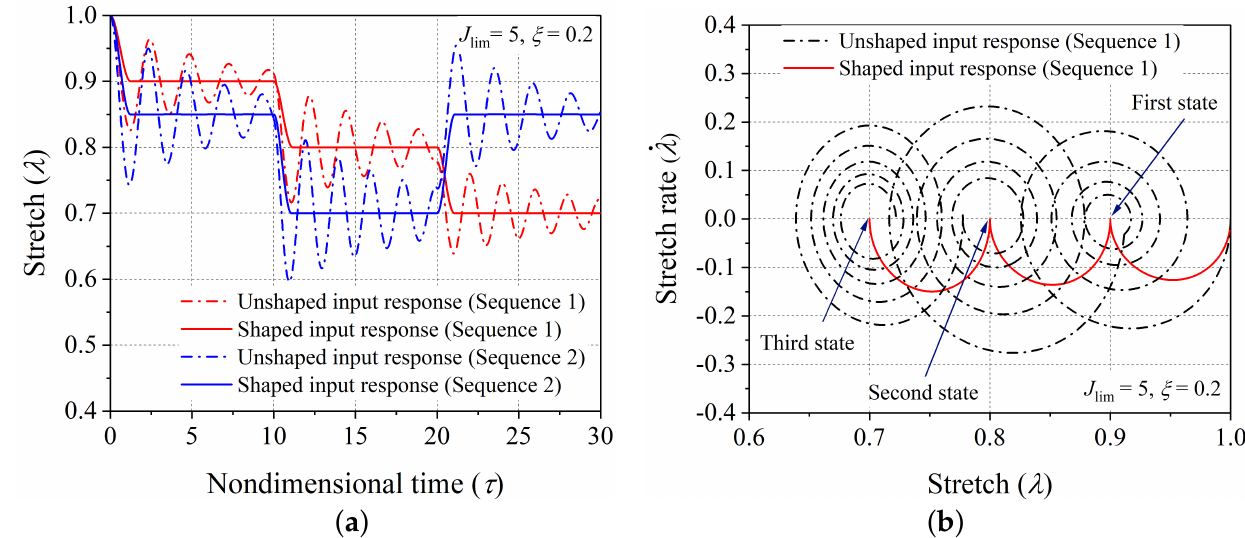
Figure 6. ( a ) The controlled transient response (corresponding to shaped input signal) and uncon- trolled transient response (corresponding to unshaped input signal) for the two chosen equilibrium sequences ((0.90, 10), (0.80, 10), (0.70, 10)) and ((0.85, 10), (0.70, 10), (0.85, 10)) of the hard-magnetic soft actuator, and ( b ) the uncontrolled (corresponding to unshaped input signal) and controlled (corresponding to shaped input signal) phase − plane plots for the chosen ((0.90, 10), (0.80, 10), (0.70, 10)) equilibrium